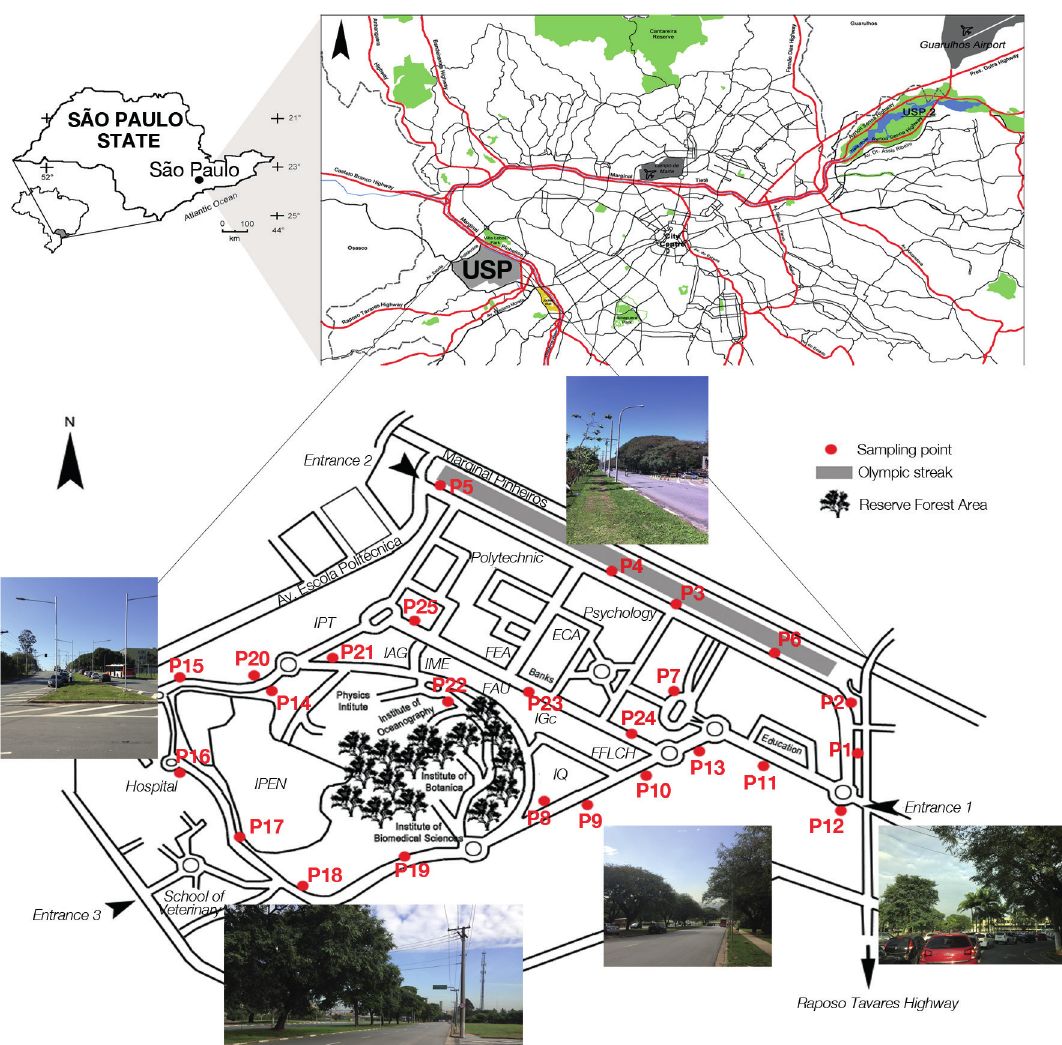
Figure 1 - Topsoil sampling sites located at the campus (green area) of the University of São Paulo, in the west zone of the São Paulo